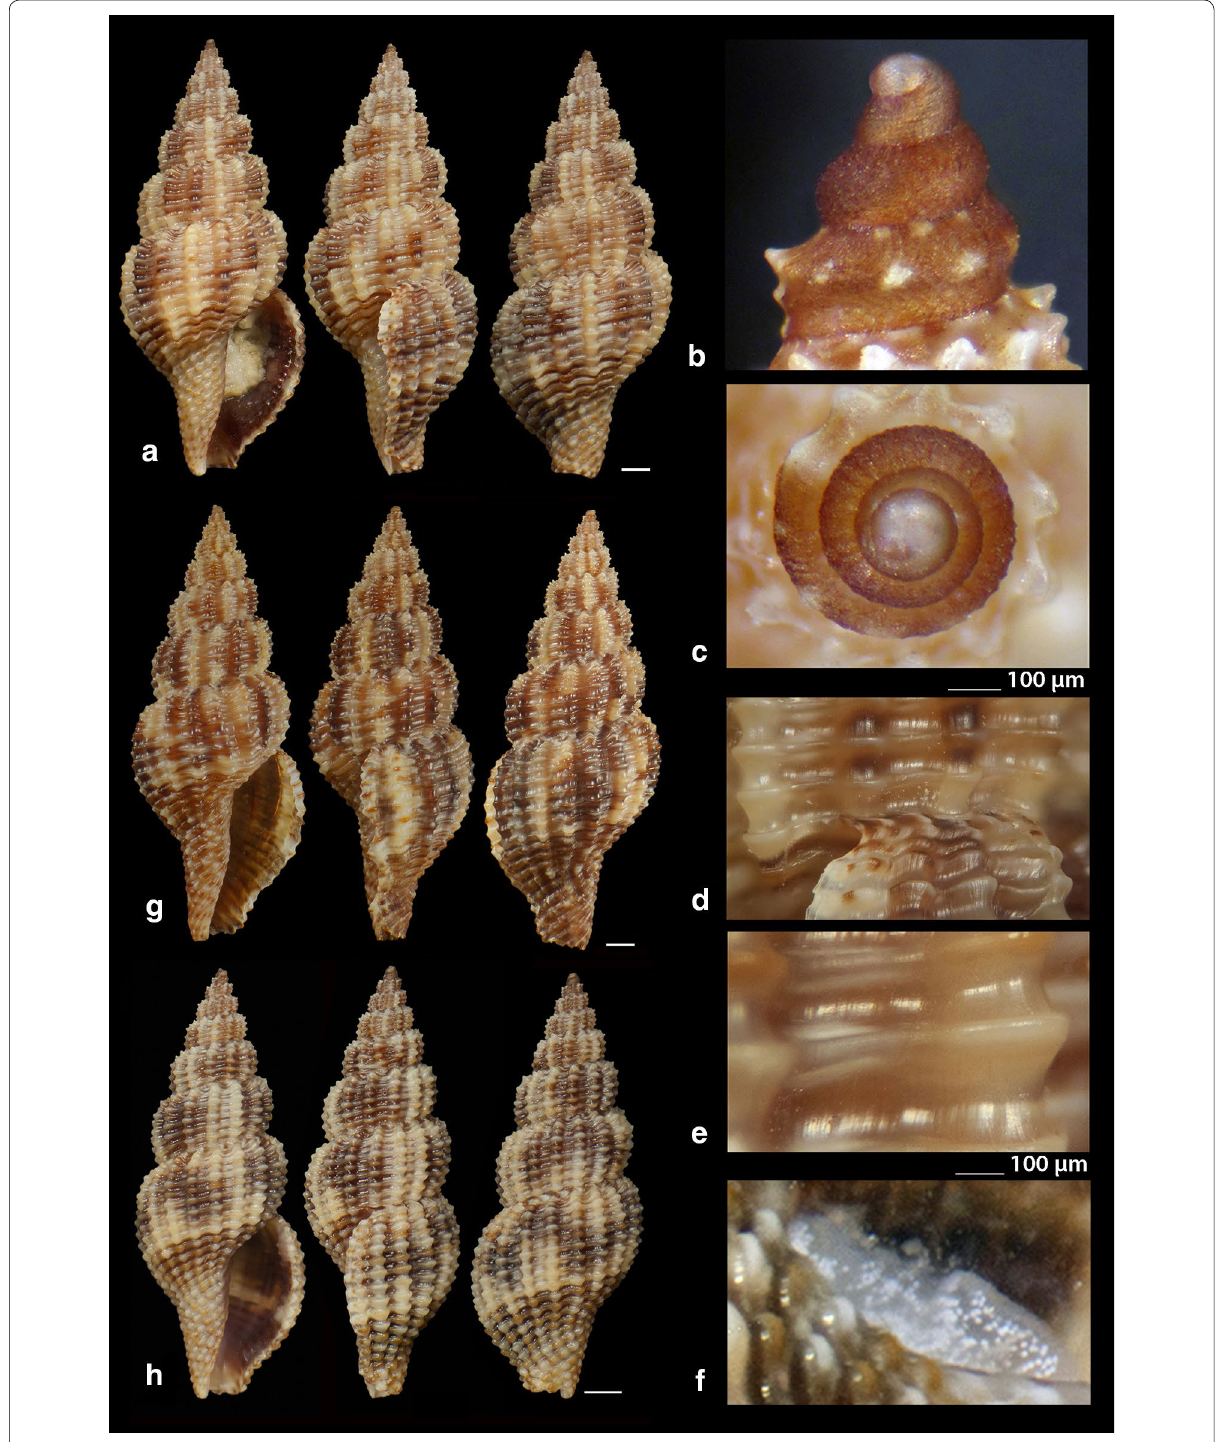
Fig. 22 a – f Raphitoma sophiae sp. n., a holotype (15.55 mm), b , c protoconch, d ornamentation by the posterior siphonal canal, e surface, f animal foot, g Paratype 1 (15.10 mm), h Paratype 2 (11.25 mm). Scale bar